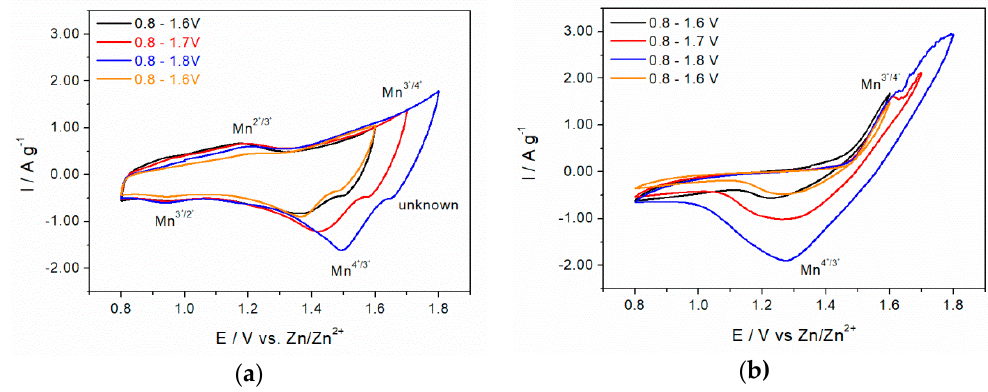
Figure 8. Influence of potential window on δ -MnO 2 (14 h @ 110 °C in 1.6 M KOH) voltammogram at 10 mV s − 1 in ChOAc with 0.01 M ZnOAc and 30 wt % H 2 O at 10 mV s − 1 ( a ) and in 1 M ZnSO 4 ( b).